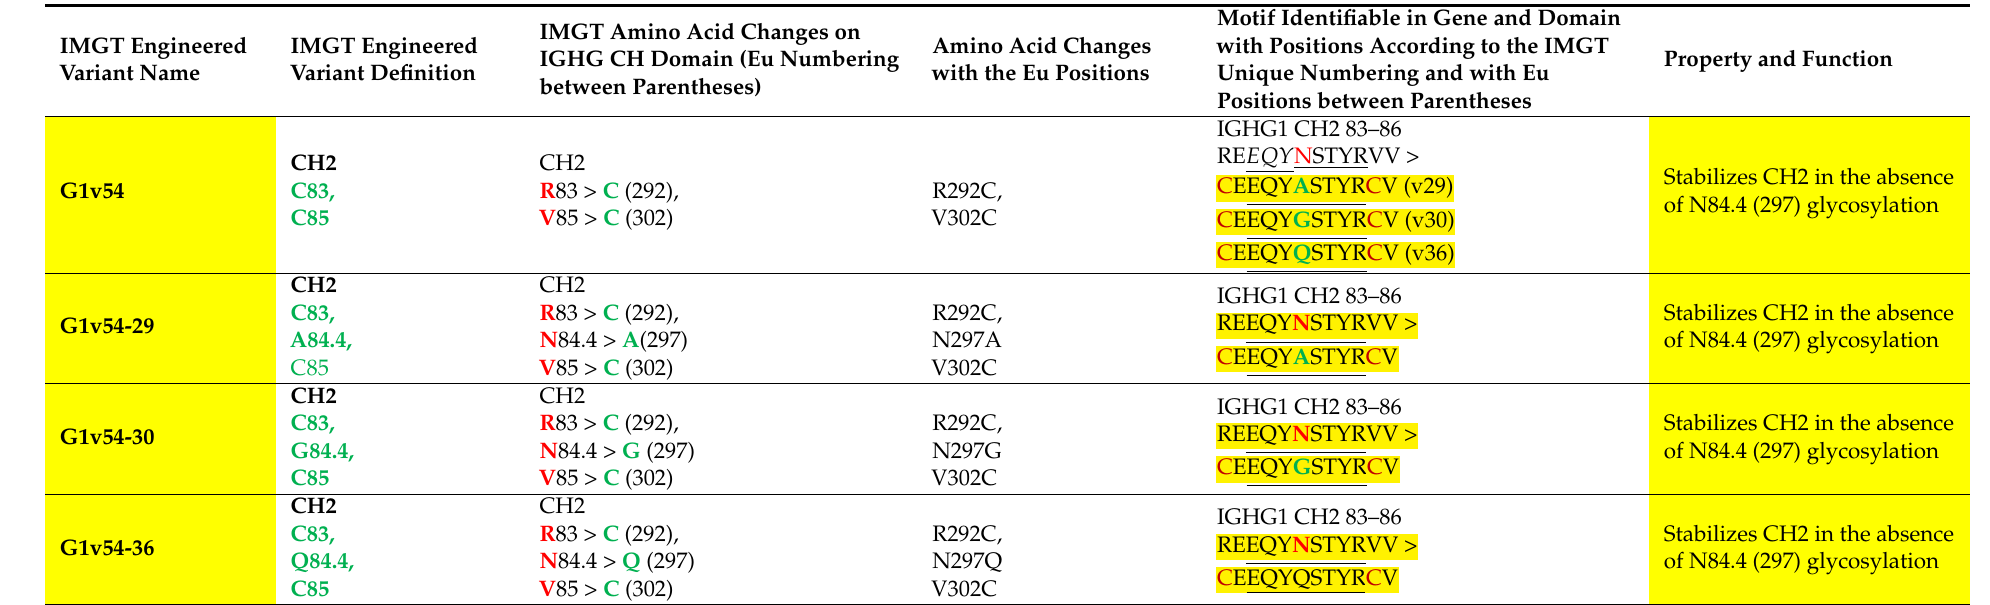
Table 15. IMGT nomenclature, Eu positions and IMGT motif of engineered Fc variants involved in the formation of additional bridge stabilizing CH2 in the absence of N84.4 (297) glycosylation (Structure